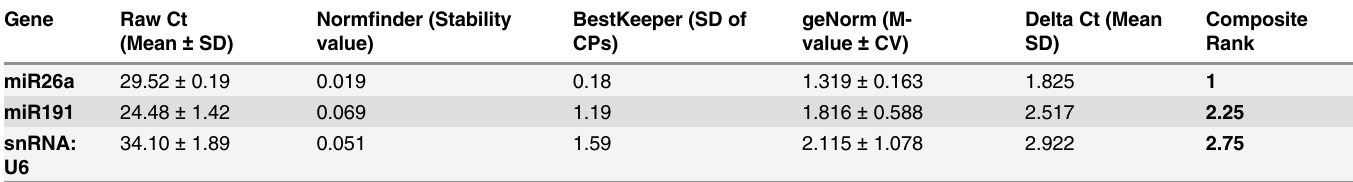
potential endogenous controls with progression of ALF was assessed using the following software packages: Norm fi nder [28]; BestKeeper [29]; geNorm [30,31]; and Delta Ct method [32]. The results from these analyses were used to form the composite rank to determine the fi nal choice of endogenous control. For a graphical representation of the stability of the endogenous controls see S1 Fig. Ct, threshold cycle; SD, standard deviation; CPs, crossing points; M-value, gene stability value; CV, coef fi cient of